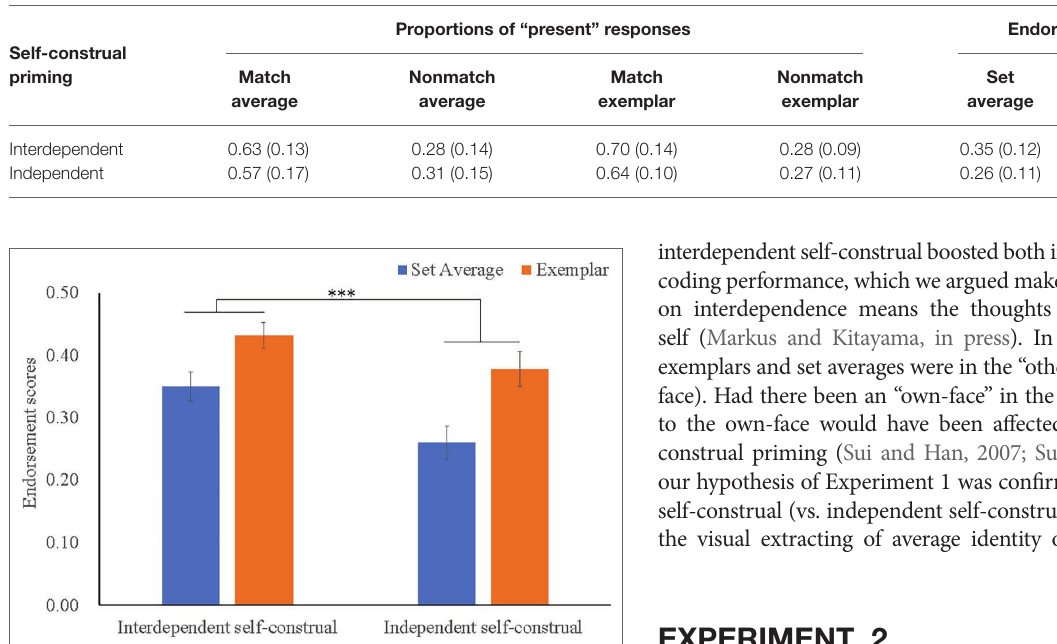
TABLE 1 | Descriptive data of experiment 1.